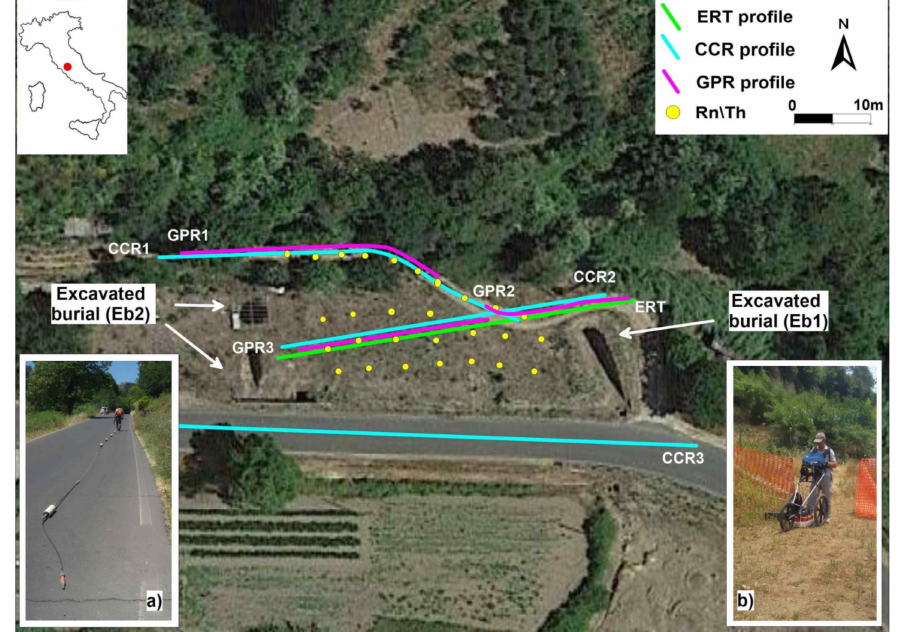
Figure 3. Location map of the geophysical and geochemical surveys. Study area with the location of the geophysical and the geochemical surveys. Insets show ( a ) CCR and ( b ) GPR survey oper- ations, wherein the solid-yellow dots indicate the sampled geochemical data, the light-blue solid lines indicate the CCR profiles, while the solid purple and green lines show the GPR and the ERT profiles,